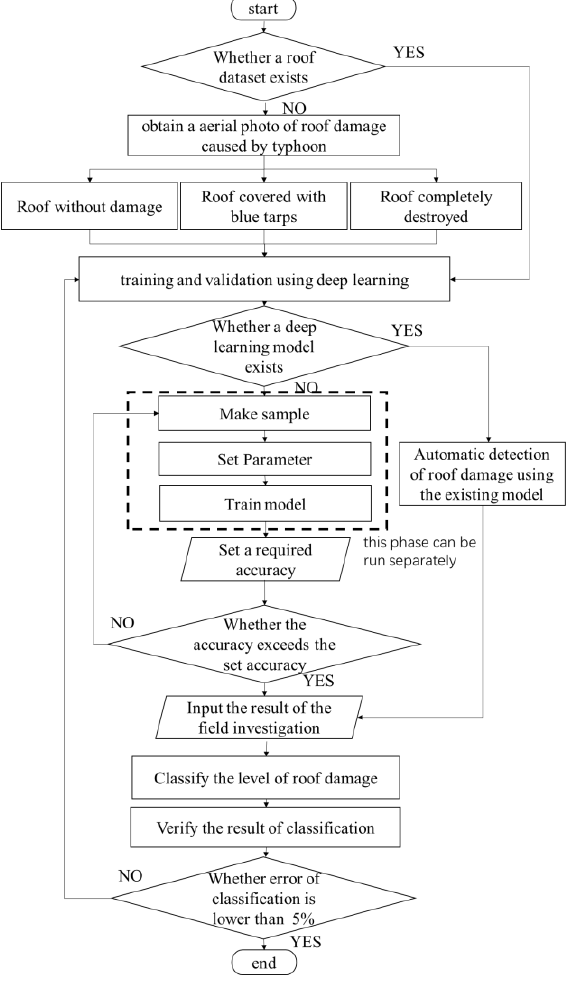
Figure 2. Flowchart of detection and classification of damage roof.